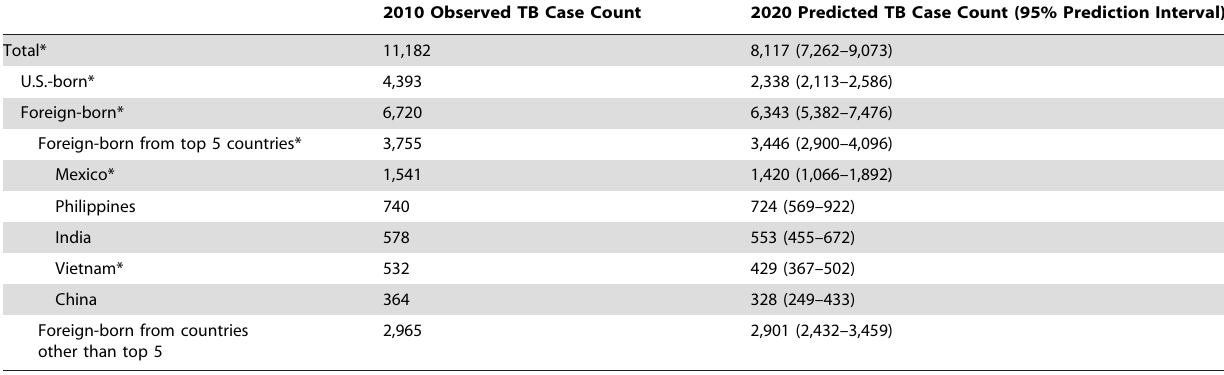
Table 1. 2010 observed and 2020 predicted tuberculosis (TB) case counts and 95% prediction